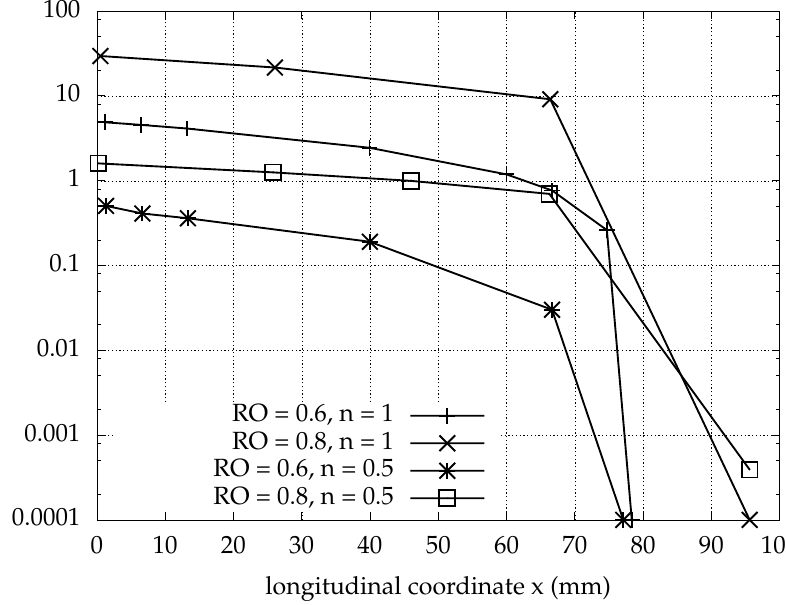
Figure 22. Peristalsis characteristics for roller pumps 90 mm long and one roller moving with c = 5 mm/s using the logarithmic scale for